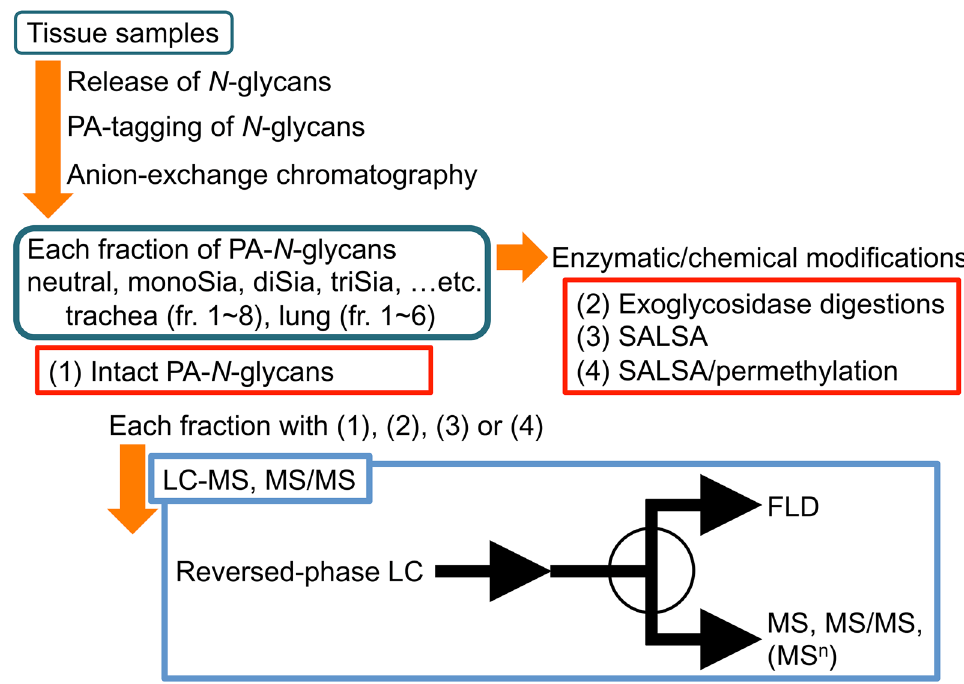
Figure 1. Workflow of procedural steps for structural analysis of N -glycans from chicken tissues. N -Glycans are released enzymatically from tissue glycoproteins, and labeled with PA. After partial fractionation of PA- N - glycans based on their negative charge on an anion-exchange column, each fraction, which contains intact PA- N -glycans (1), is subjected to LC–MS and MS/MS analysis using a reversed-phase column to obtain an overview of the structural features of tissue glycans. Eluents from the column are separated evenly (1:1) using a splitter, and PA-glycans are detected simultaneously using a MS system and a fluorescence detector (FLD). Glycan structures, including anomeric configurations, are confirmed by a combination of exoglycosidase digestions (2). The branching/core structures of N -glycans can be confirmed based on their elution positions, as well as LC–MS and MS/MS analysis, after exoglycosidase digestions. Linkages of sialic acids on sialylated glycans are determined and quantified by SALSA (3), followed by LC–MS and MS/MS analysis. Permethylation of alkylamidated glycans (4) followed by LC–MS, MS/MS, and MS n analysis accompanied by cross-ring cleavages is useful for further determination of glycosidic linkage positions in some